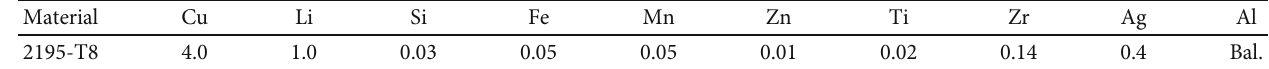
Table 1: Chemical composition of 2195-T8 Al-Li alloy